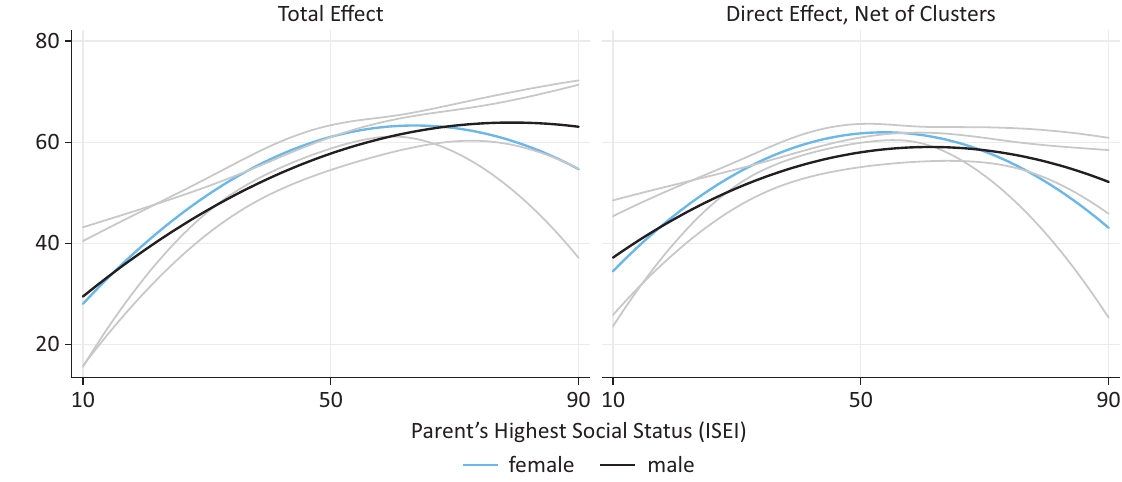
Figure 6. Predictions of social status (ISEI) in 2014 (age ~30) by parental social status (ISEI) and gender, grey lines: 95%-CI.